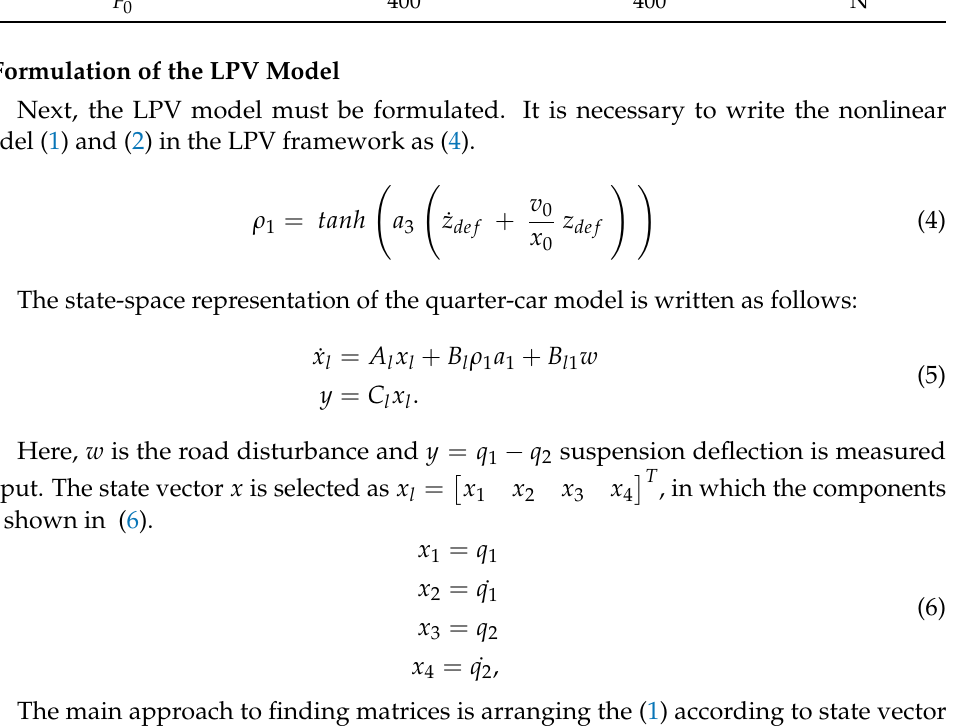
Table 1. Parameters of MR damper and quarter-car. Parameters Front Rear (Symbols) Suspension Suspension Sprung mass ( m s ) 214 336 kg Unsprung mass ( m u ) 40 40 kg Suspension Stiffness ( k s ) 30 60 kN/m Tire stiffness ( k t ) 220 220 kN/m Damping ( b mr ) 50 50 N/m/s a 2 1500 1500 Ns/m a 3 129 129 s/m v 0 0.788 × 10 − 3 0.788 × 10 − 3 m/s x 0 1.195 × 10 − 3 1.195 × 10 − 3 m F 0 400 400